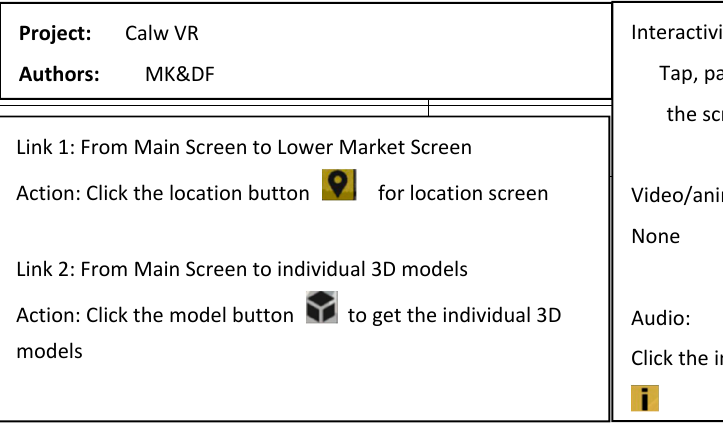
Figure 4. Excerpt of the storyboard’s main menu of the Calw VR App.